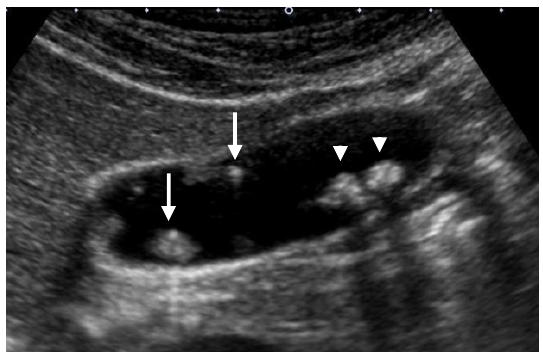
Figure 5. Hyperechoic spots and aggregations of echogenic spots (mulberry echo pattern). A high- frequency transducer depicted hyperechoic spots (arrow) and aggregations of echogenic spots with acoustic shadow (arrowhead) (cholesterol polyps).